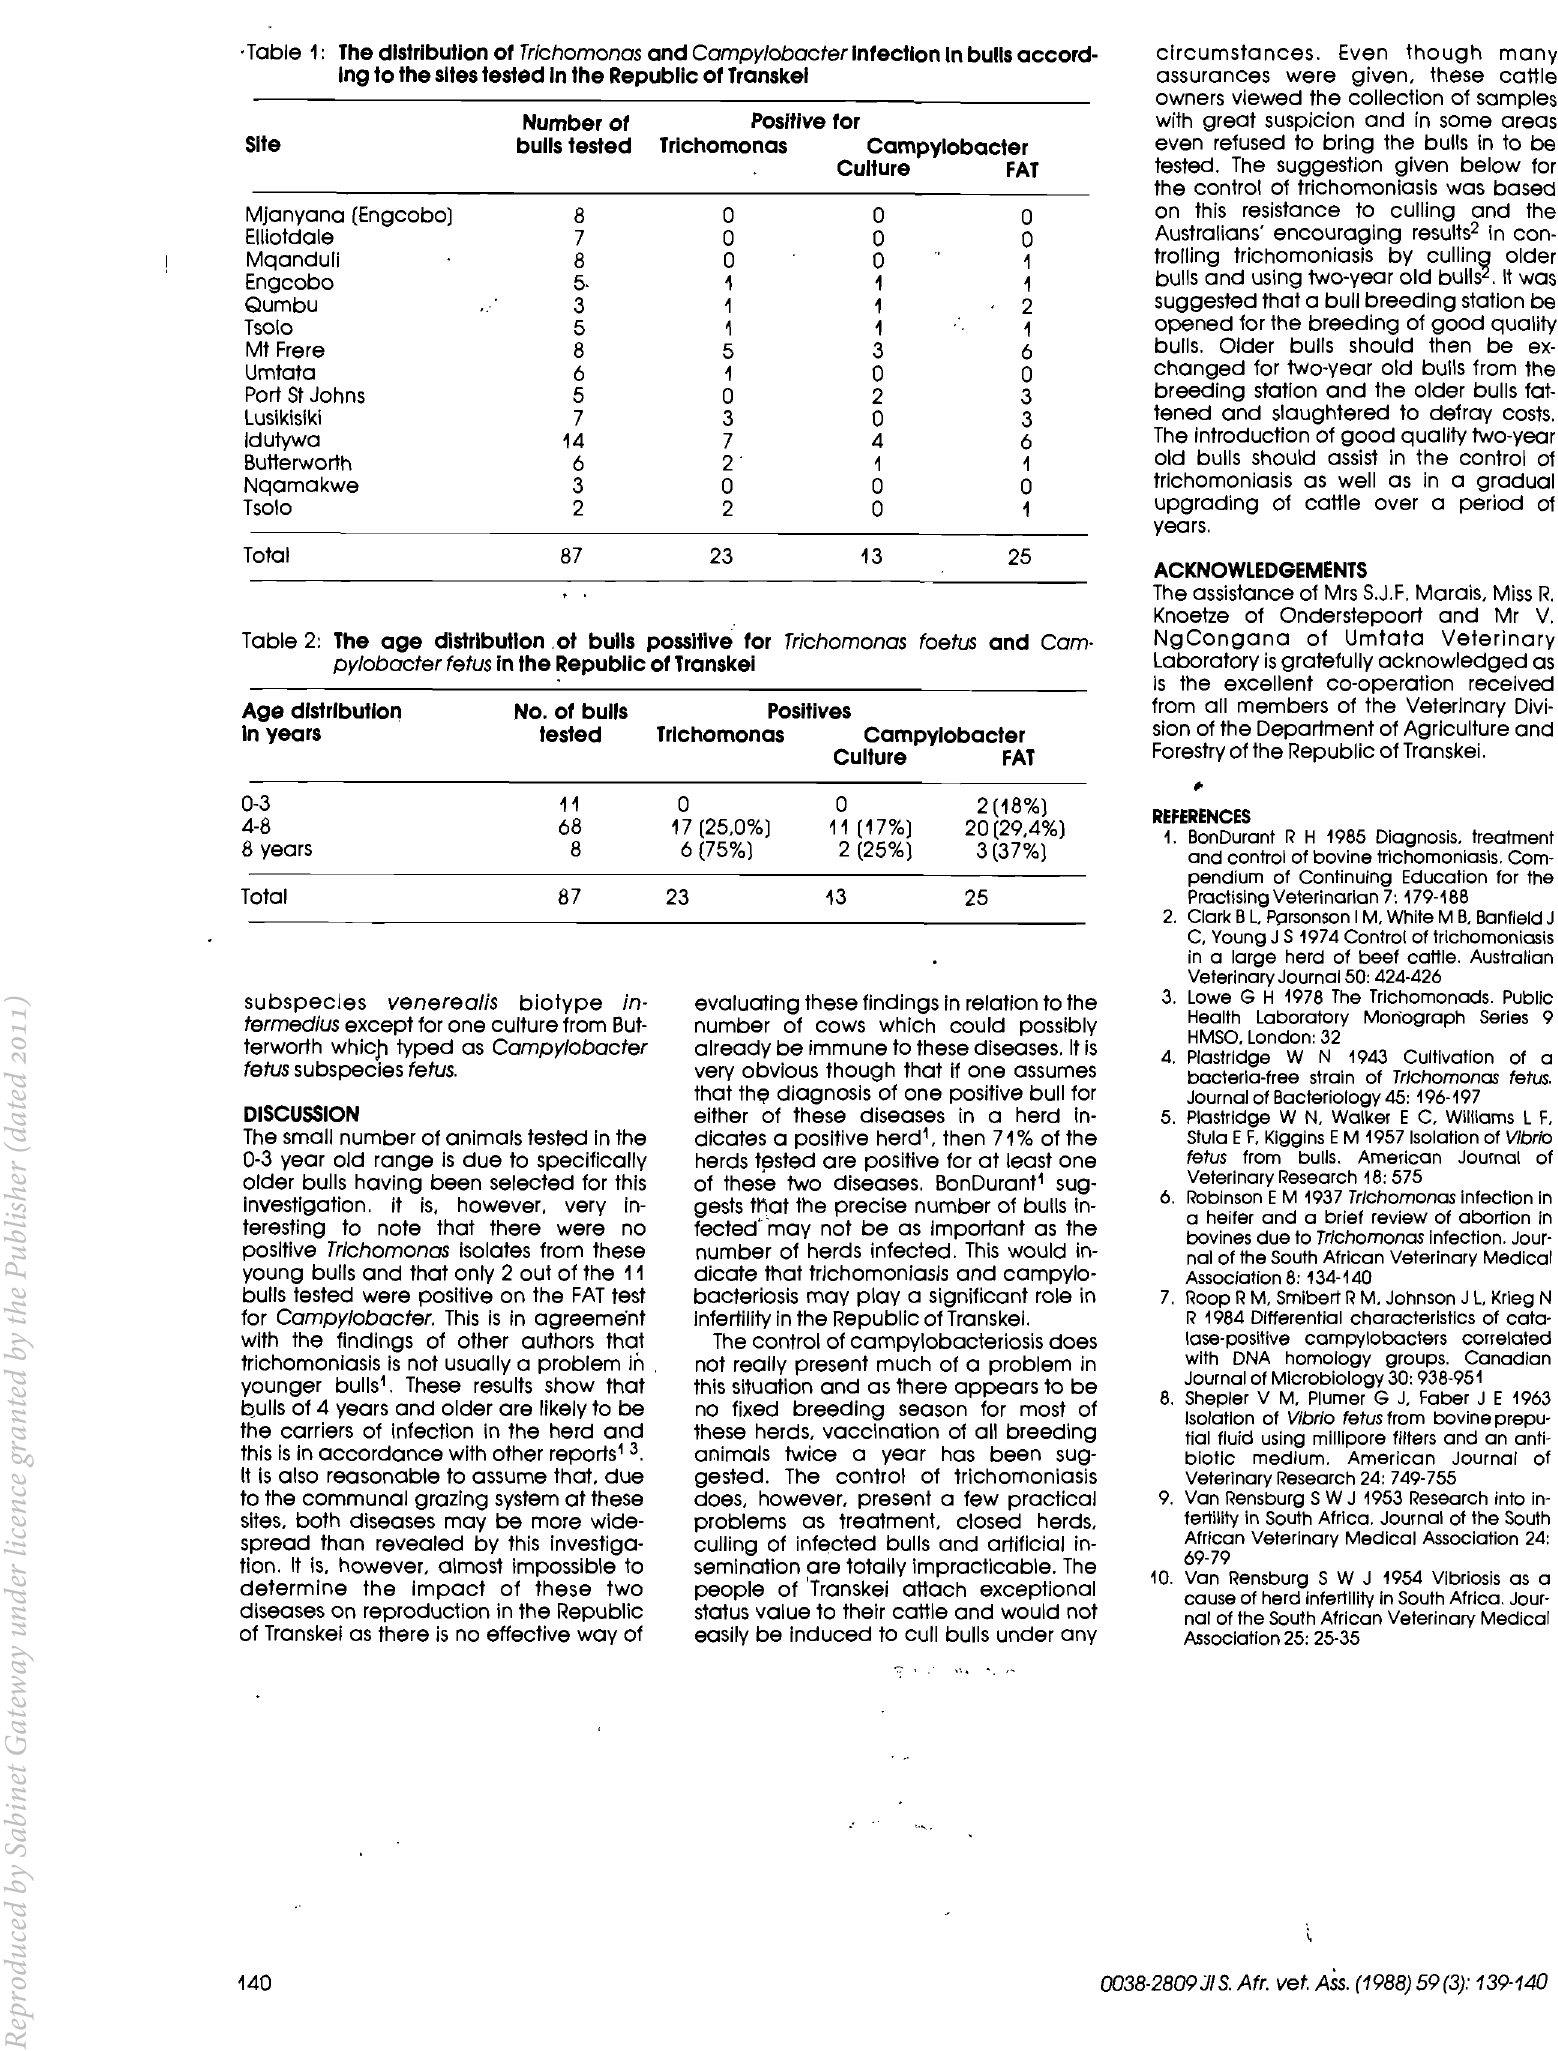
· Table 1: The distribution ot Trichomonas and Campy/obacter Intectlon In bulls accord Ing to the sites tested In the Republic ot Transkel